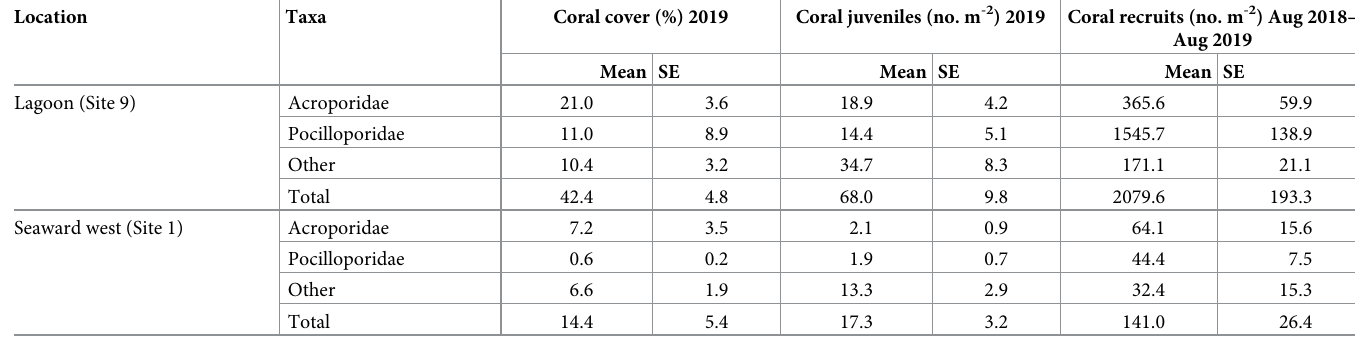
Table 2. Percentage coral cover, coral juvenile abundances and coral recruit abundances at the two study sites in Aldabra’s lagoon and the seaward west. Location